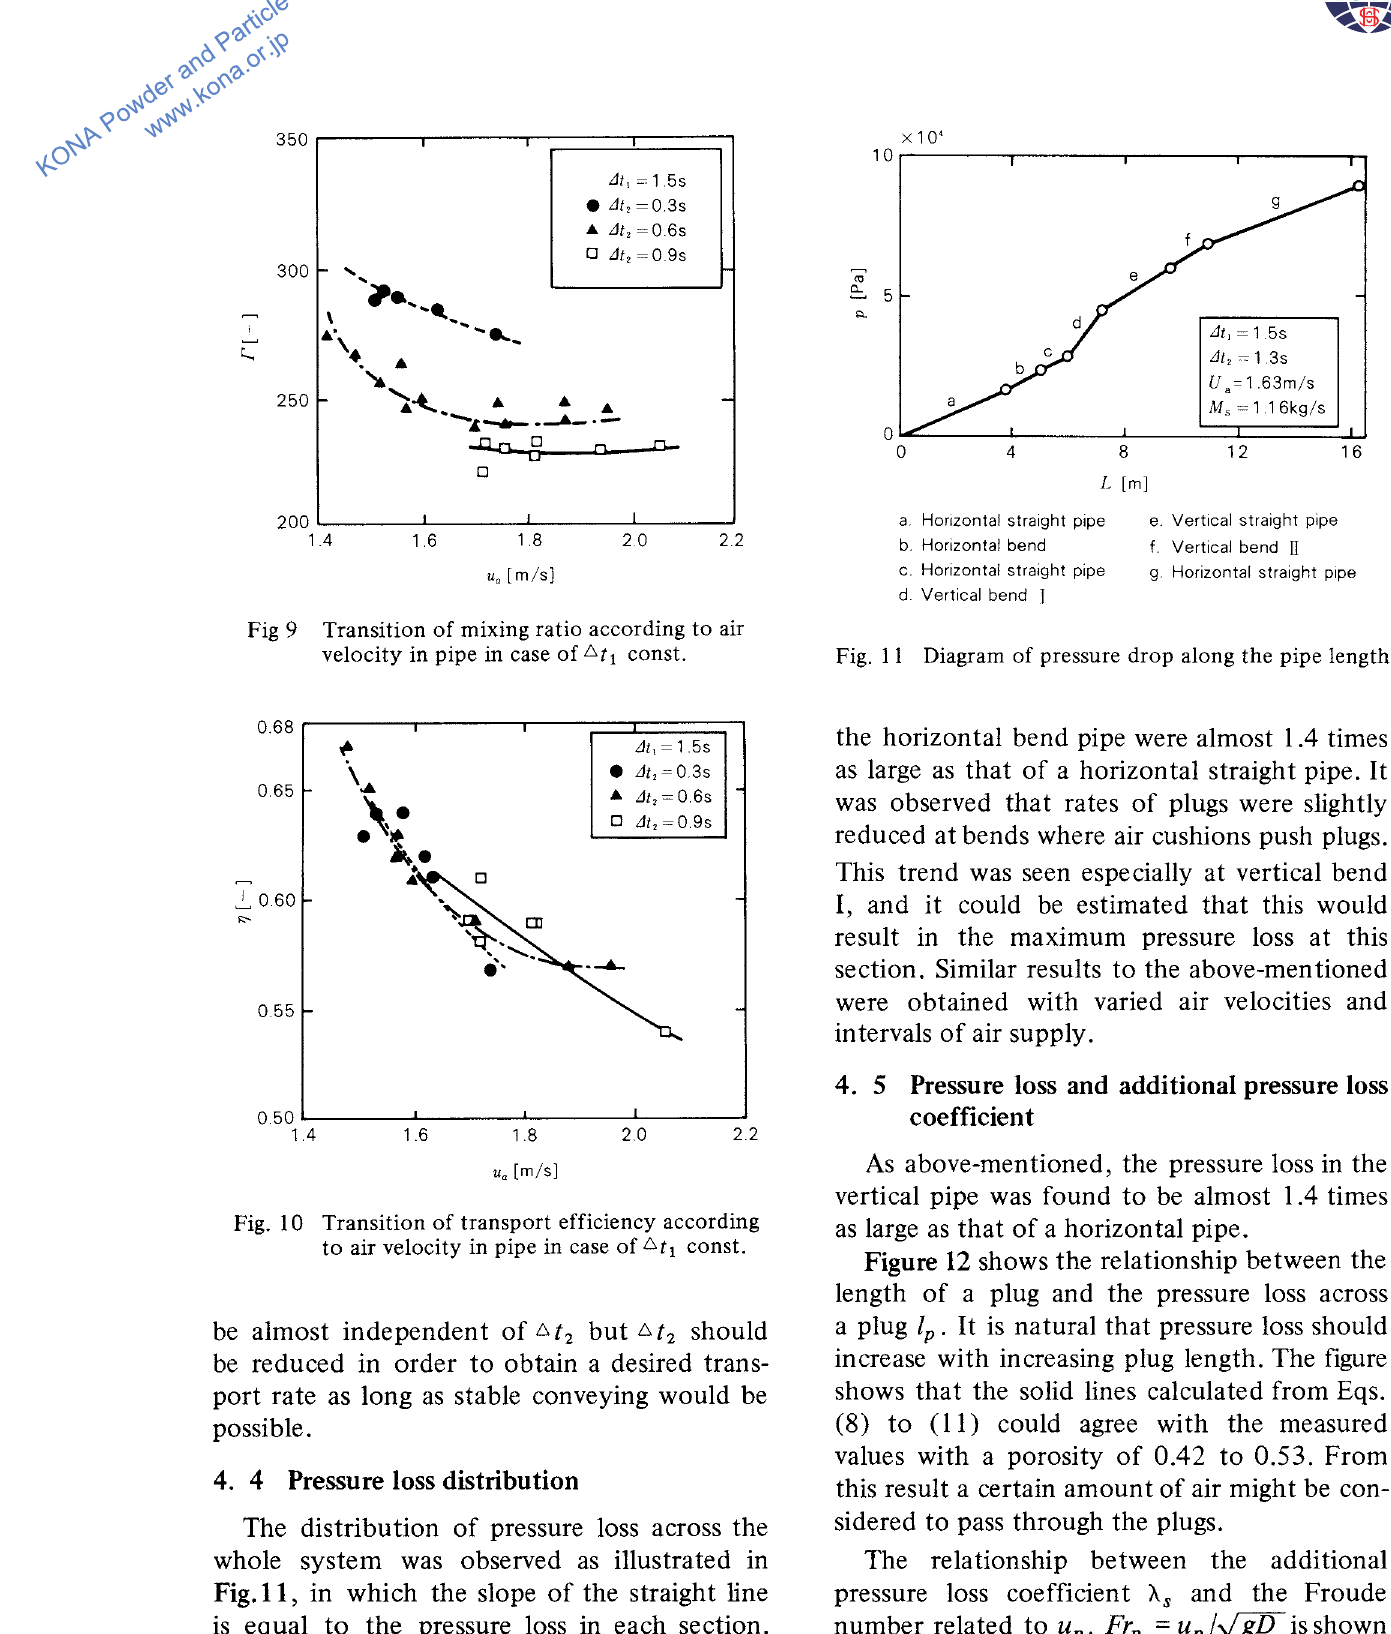
Fig 9 Transition of mixing ratio according to air velocity in pipe in case of Lit 1 const.